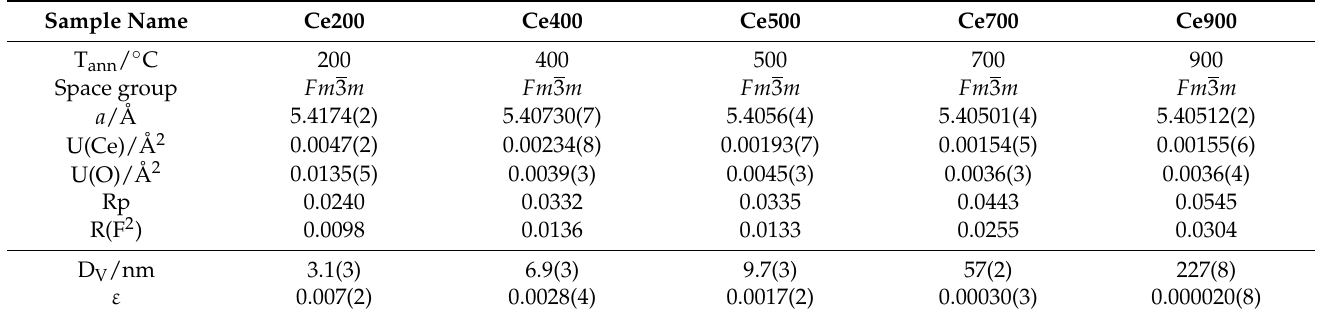
Table 1. Outcomes of Rietveld refinements and WH analysis as a function of the annealing